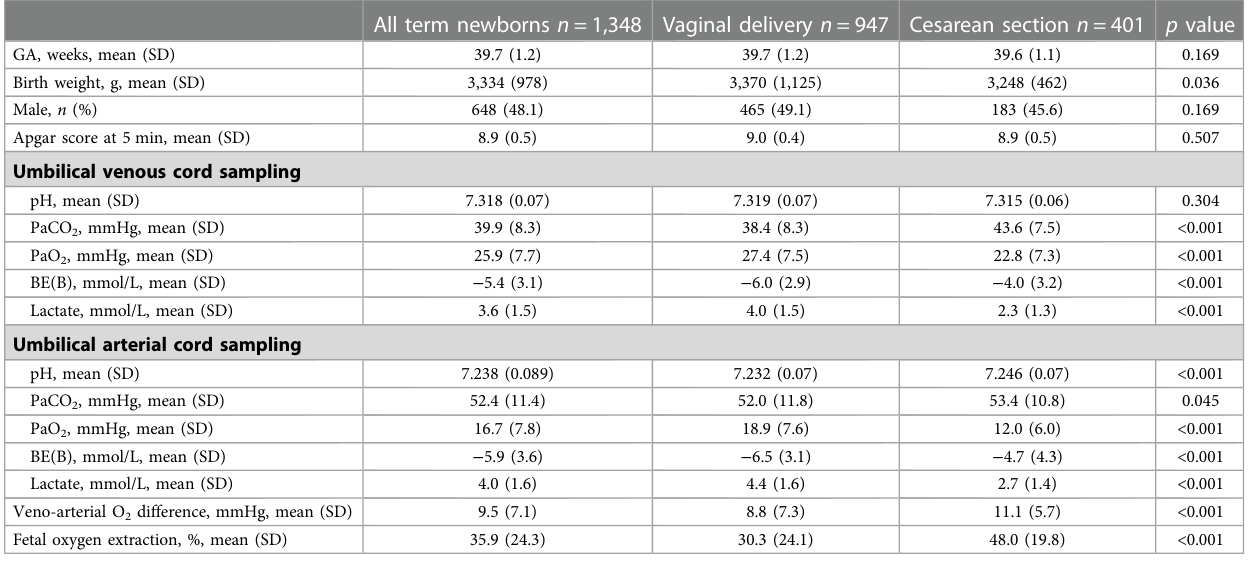
TABLE 1 Umbilical-cord blood gas analysis in all enrolled term newborns and separately analyzed by the type of delivery.